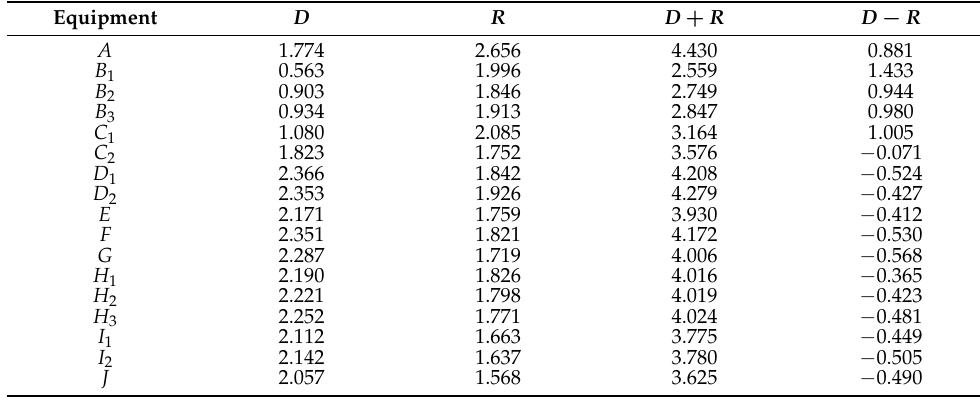
Table 6. Results of the fuzzy DEMATEL